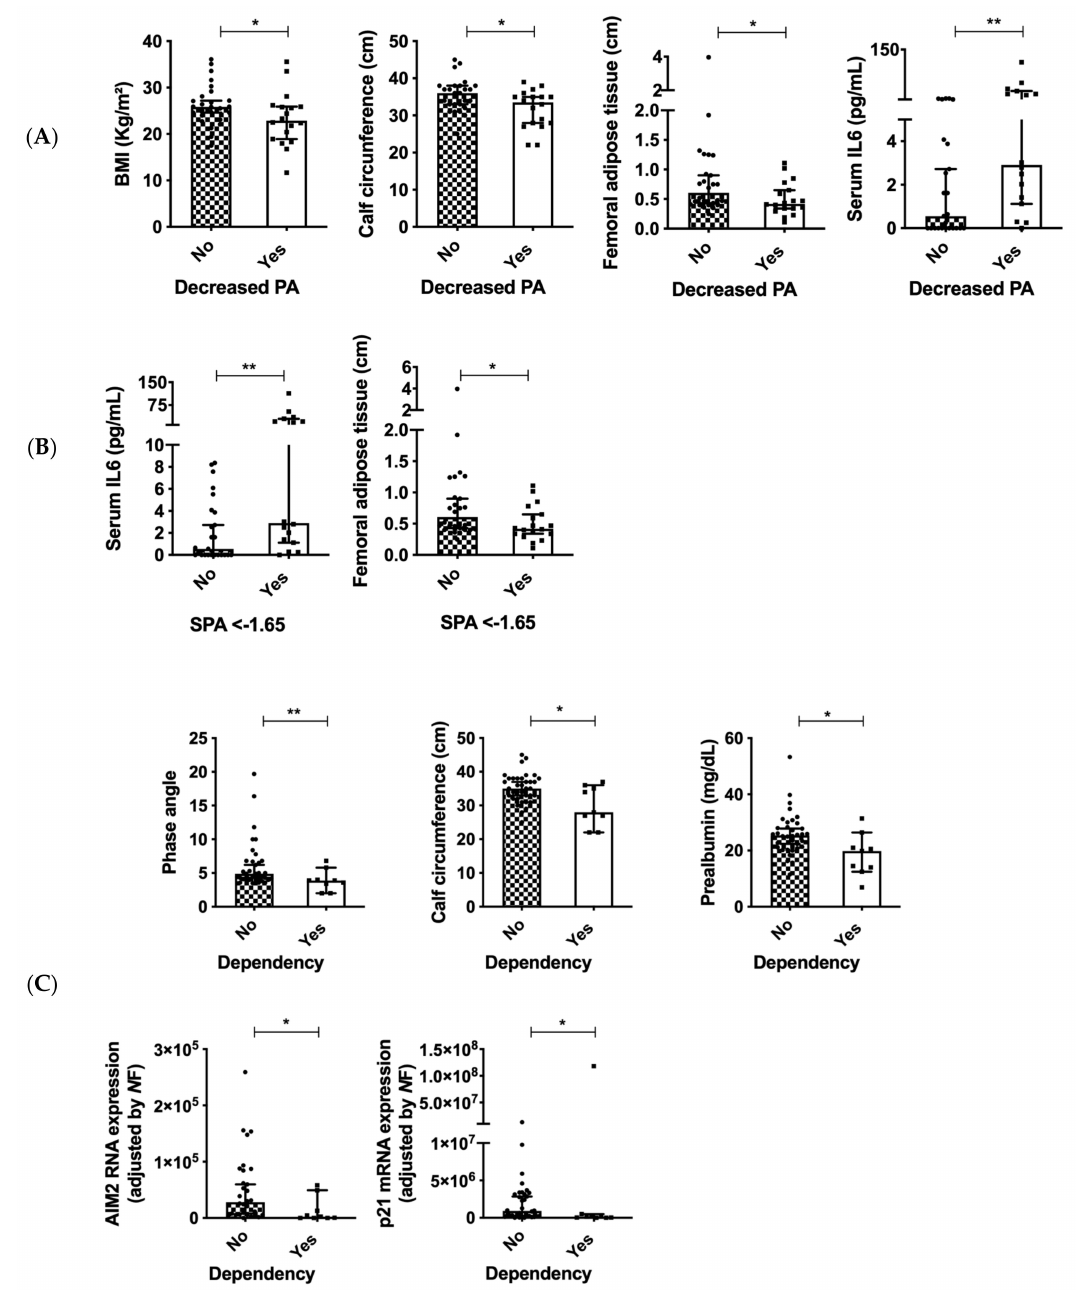
Figure 6. ( A ) Clinical and molecular associations in patients with decreased PA, SPA ( B ) and any level of dependency ( C ) in patients with head and neck cancers. Legend: *: p < 0.05; **: p < 0.01. 3.7. Serum Inflammation Markers as Indicators of Nutritional Status in Patients with Head and Neck